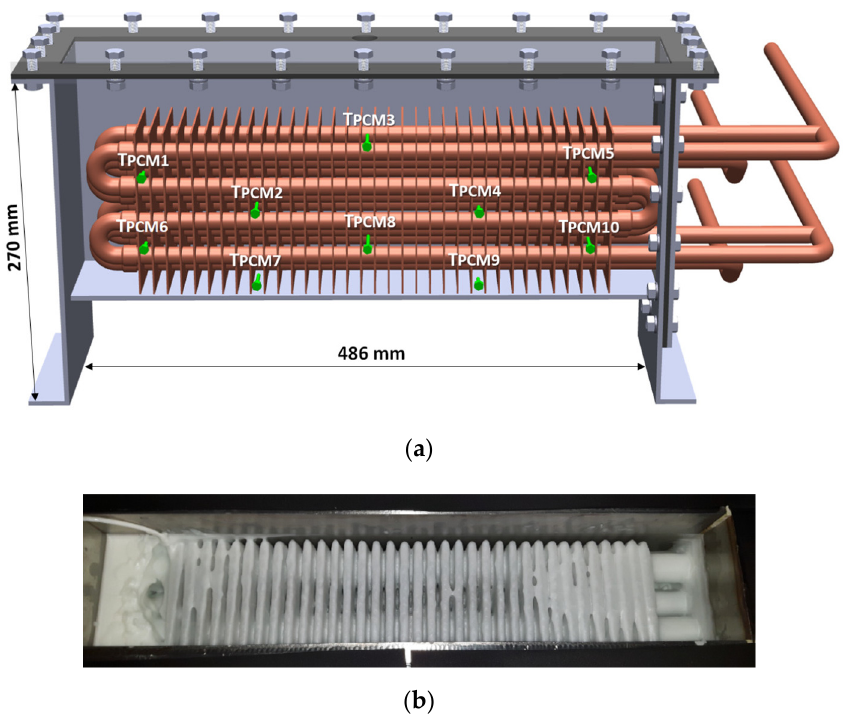
Figure 5. ( a ) Compact rectangular shell-tube LHS with positions of temperature sensors, ( b ) photo of the interior at the beginning of the melting process (Copyright 2021 Pakalka et al. (https://creativecommons.org/licenses/by/4.0/), accessed on 26 September 2022 [29]. Table 3. Parameters of LHS (Figure 5) (adapter, copyright 2021 Pakalka et al. (https://creativecom- mons.org/licenses/by/4.0/), accessed on 26 September 2022 [29].